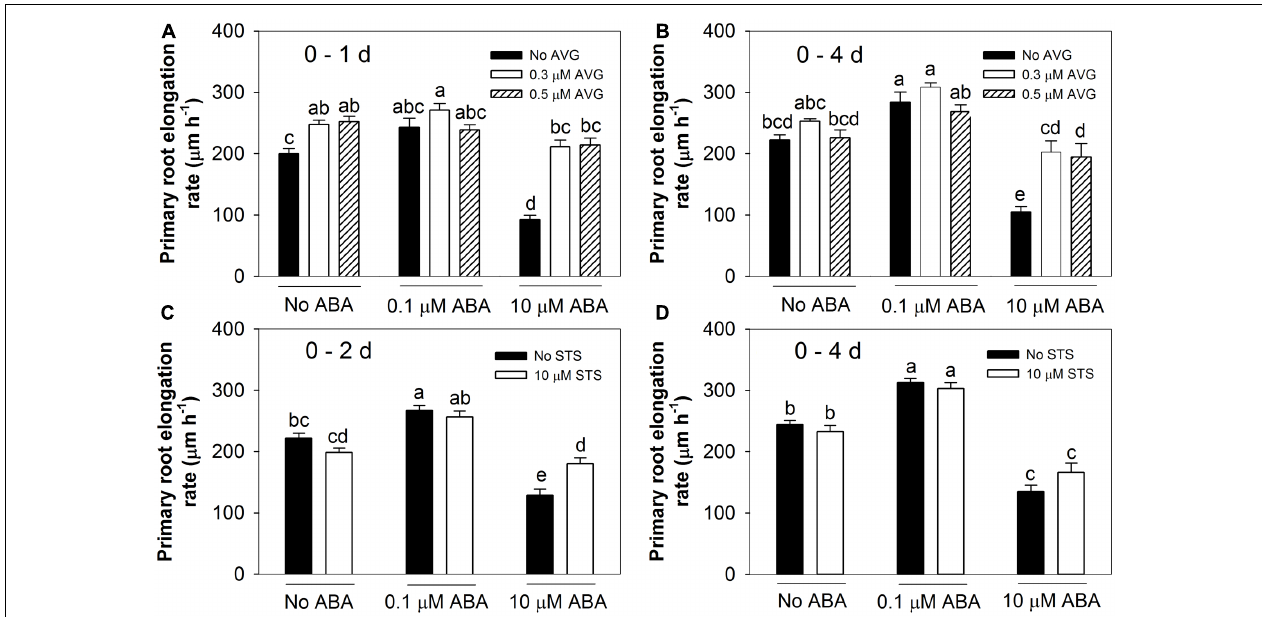
FIGURE 2 | Ethylene biosynthesis and signalling inhibitors altered root responses to ABA treatments. AVG: ethylene biosynthesis inhibitor. STS: ethylene signalling inhibitor. (A) The effects of AVG after 1 day. (B) The effects of AVG over a 4-day period. (C) The effects of STS during the first 2-day period. (D) The effects of STS during 4 days. Col-8 seedlings were germinated, chosen and transferred to medium as described in Figure 1 . The medium was treated with various ABA and AVG/STS concentrations ( µ M). Primary root length was marked after transplanting and the increase of primary root were measured every day. The root elongation rate was calculated for the 1 or 2 days and 4 days after treatments on average. The values are means, and the vertical bars represent standard errors of the means. Data analysed using one-way ANOVA with Tukey’s post hoc test and different letters indicate significant differences cross all treatments at P < 0.05. Eta 2 : (A) 0.650; (B) 0.622; (C) 0.729; (D) 0.817. Seedling numbers: (A) n = 14; (B) n = 9–14; (C) n = 9–12; (D) n = 7–12. At least three independent experiments were performed and similar results obtained and